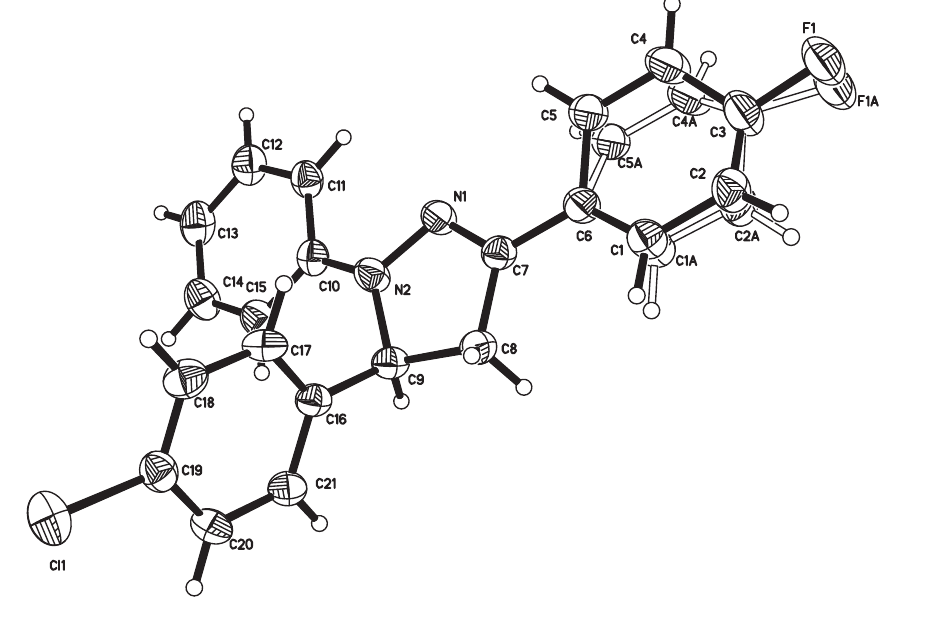
Table 1: Data collection and